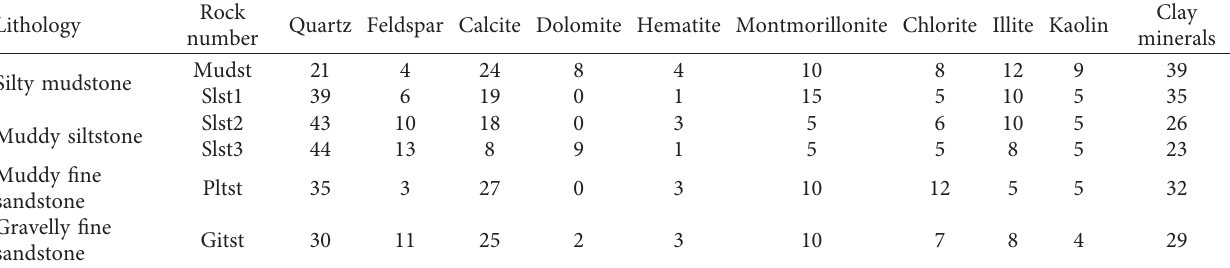
Table 2: Mineral composition of sandstone.